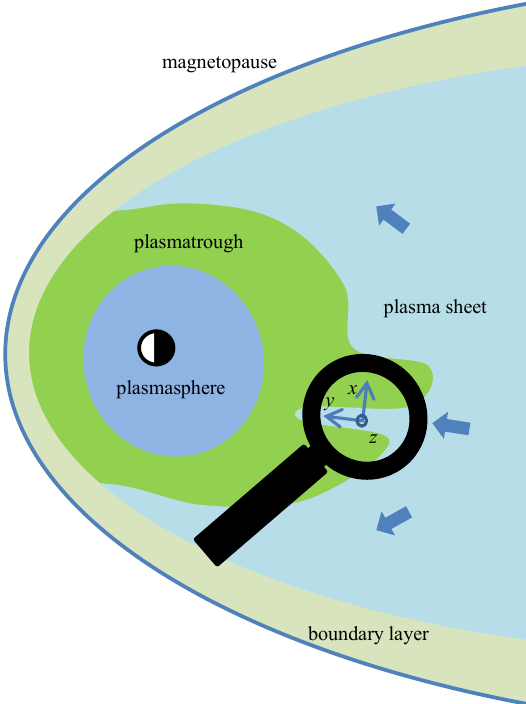
Fig. 1. Equatorial cross-section of the magnetosphere. Plasma in- jected from the plasma sheet can penetrate into the plasmatrough, thereby forming a cross-field flow channel. The magnifying glass zooms in on such a channel, which can be approximated by a 1- dimensional plasma slab geometry.